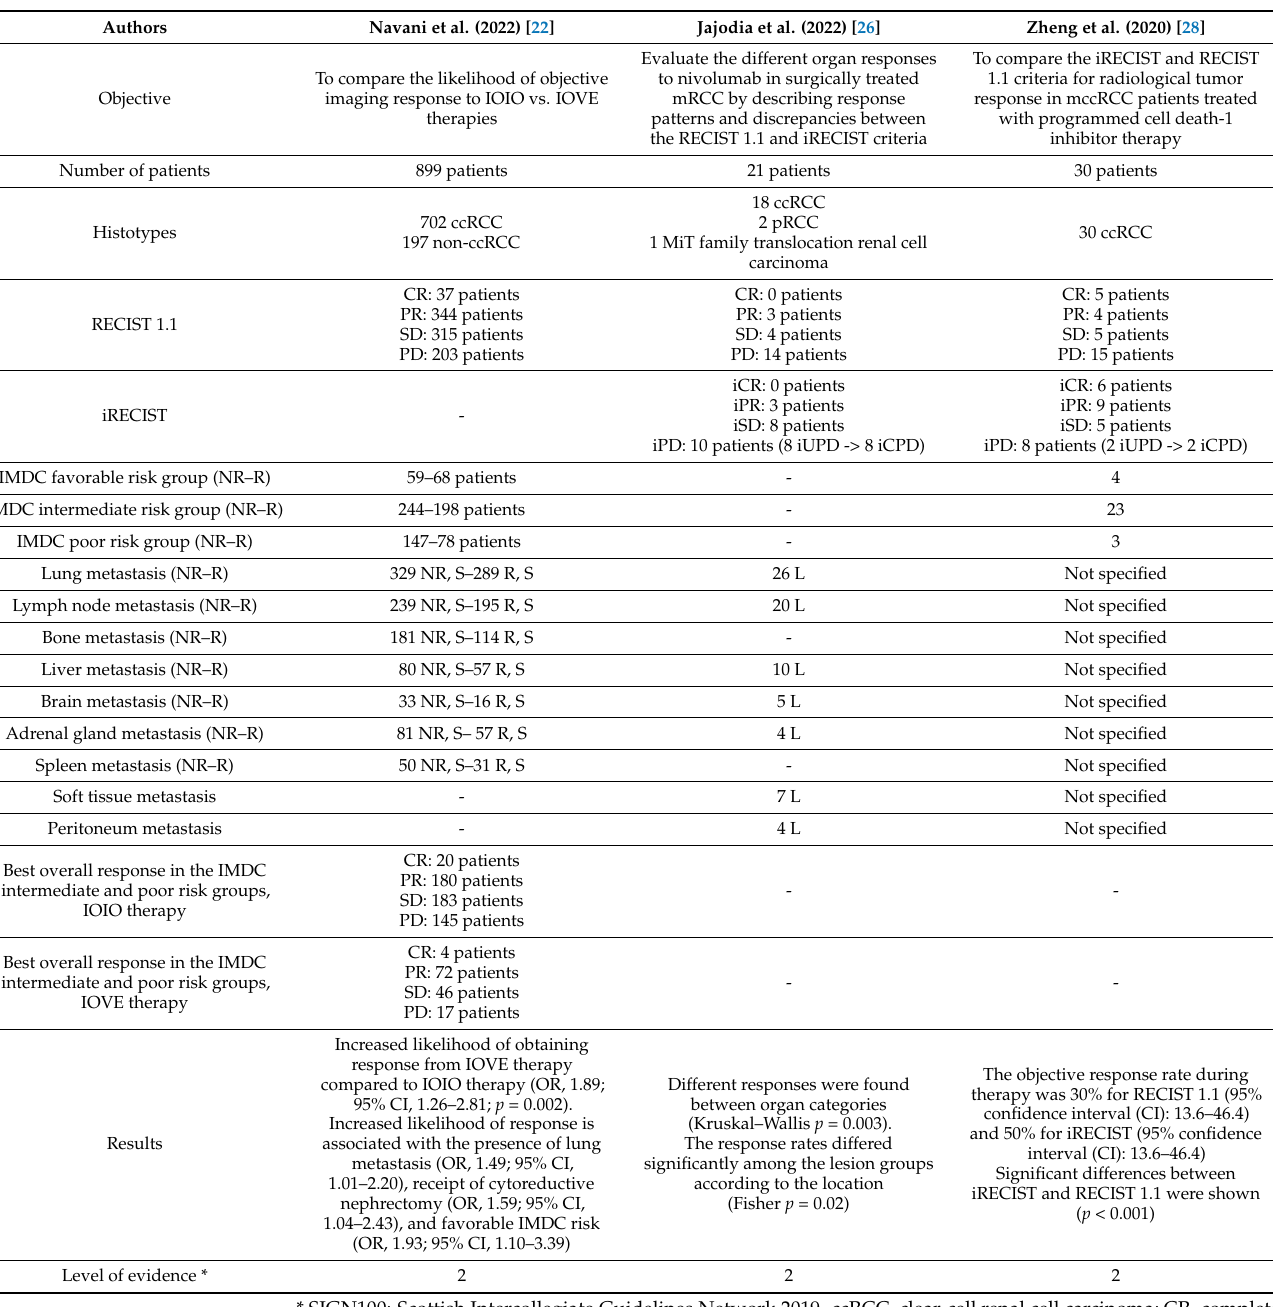
Table 1. Summary of CT clinical studies related to the RECIST criteria in mRCC patients treated with